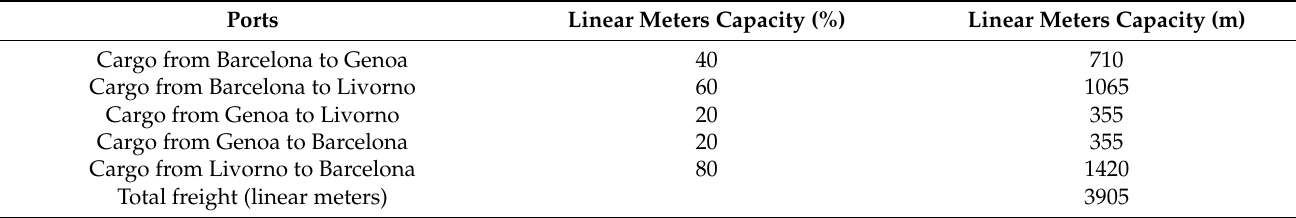
Table 10. Associated freight per port and per round-trip voyage.